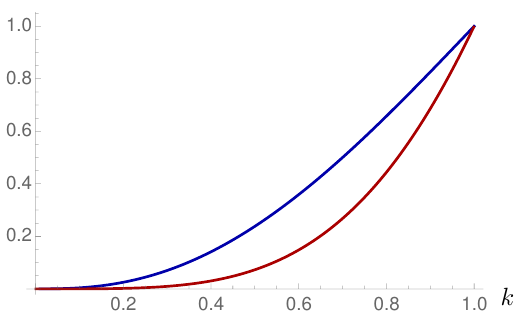
Figure 4 . Plots of S (1) (upper curve) and S (2) (lower curve) as functions of k (cid:17) K=N . The functions S (1) and S (2) can be determined numerically. Both vanish for k = 0 and ap- proach one for k ! 1. Plots are shown in (cid:12)gure 4. The (cid:12)nite part of the disc